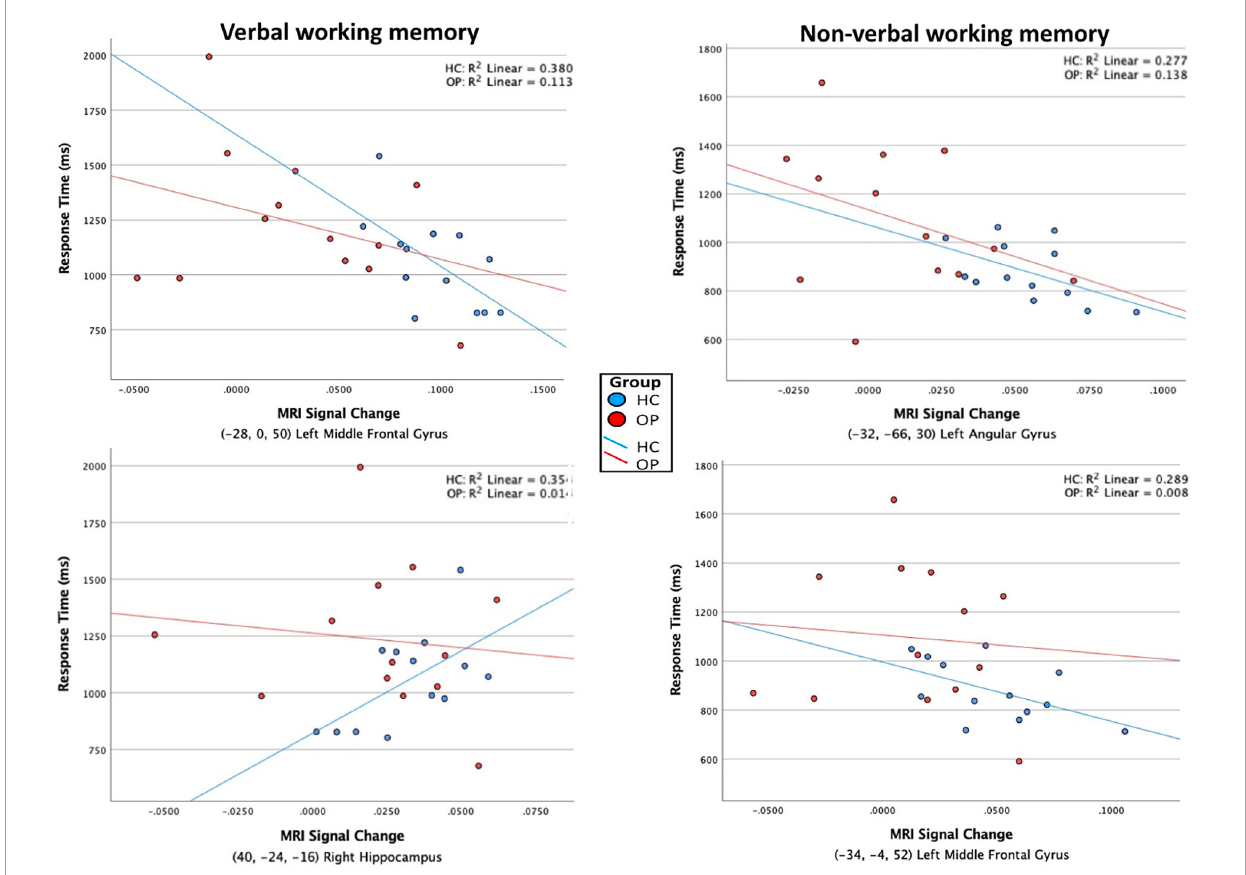
FIGURE5 Scatterplots of the association between RT and BOLD MRI signal. ROI clusters were determined by within-group contrasts between verbal – control and non-verbal – control conditions, listed in Table 4 . Significant correlations were found only in the HC group, indicated by the individual values and regression lines (blue). In the verbal WM condition (left column) , increased activity in the left middle frontal gyrus (premotor cortex, BA 6) was associated with faster RTs, whereas increased activity in the right hippocampus was associated with slower RTs. In the non-verbal WM condition (right column) , increased activity in the left angular gyrus (BA 39) and left middle frontal gyrus (premotor cortex, BA6) were associated with faster